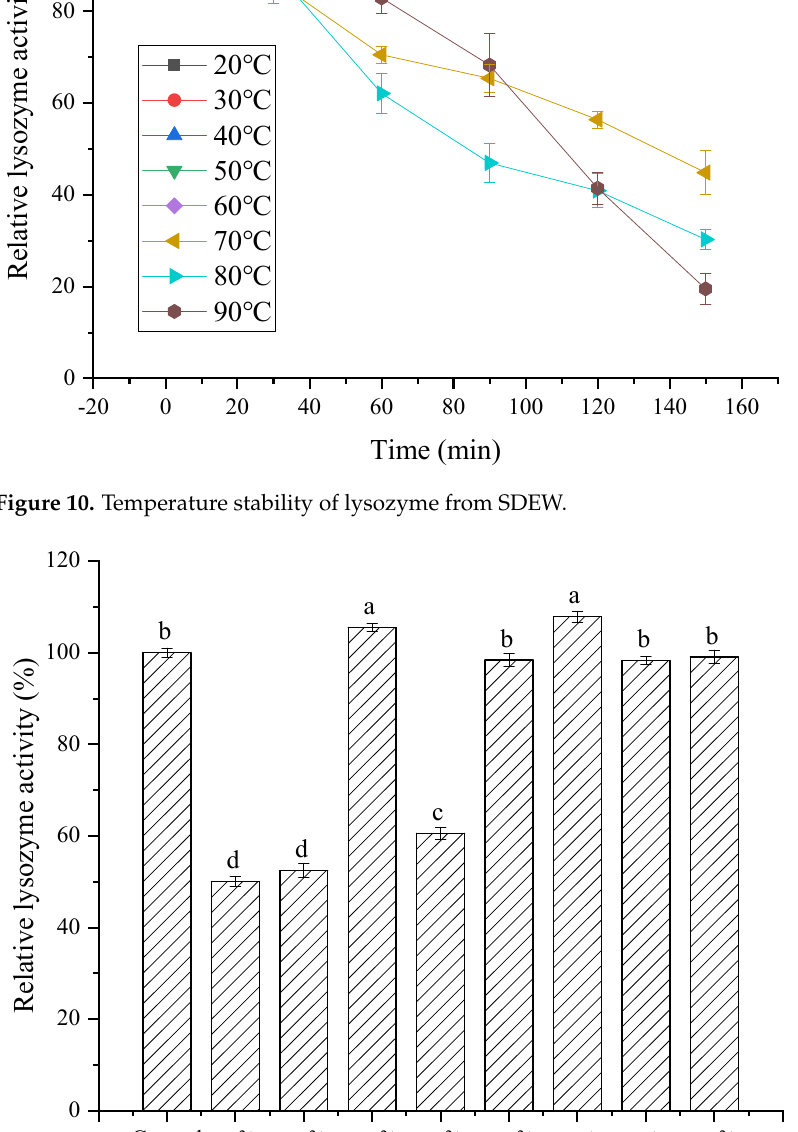
Figure 10. Temperature stability of lysozyme from SDEW.